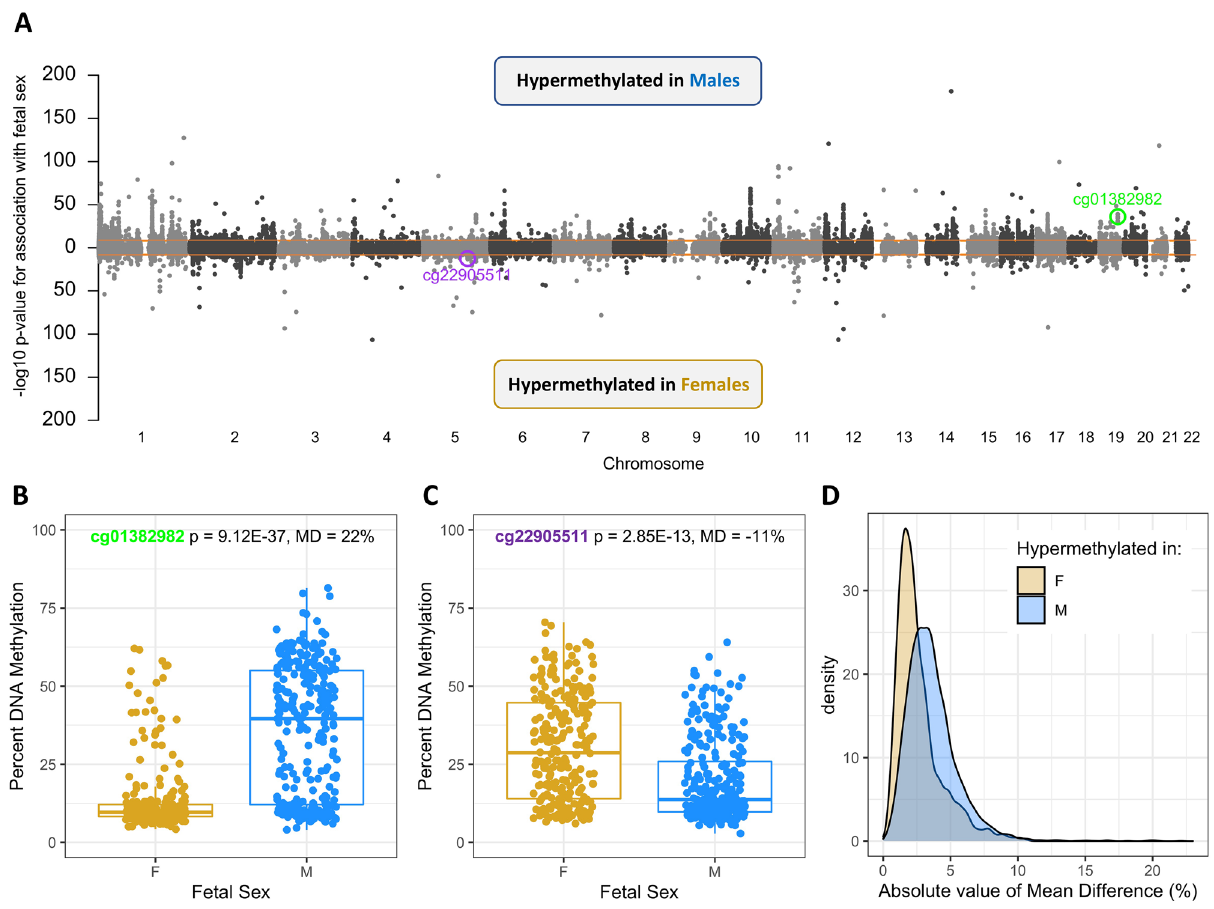
Figure 2. Single site discovery in full term placenta samples. ( A ) Manhattan plot representing results from full term samples. Top half restricted to sites hypermethylated in males, bottom half restricted to sites hypermethylated in females. Orange line represents threshold of 1E−8, the considered cutoff for genome-wide significance. ( B ) Boxplots of percent methylation in males (blue) and females (gold) at cg01382982, the genome- wide significant CpG site at which males were most hypermethylated relative to females (Mean Difference, MD = 22%). ( C ) Boxplots of percent methylation in males (blue) and females (gold) at cg22905511, the genome- wide significant CpG site at which females were most hypermethylated relative to males (Mean Difference, MD = − 11%). ( D ) Distribution of absolute value of mean differences in sites hypermethylated in males (blue, n = 3793) and sites hypermethylated in females (gold, n =